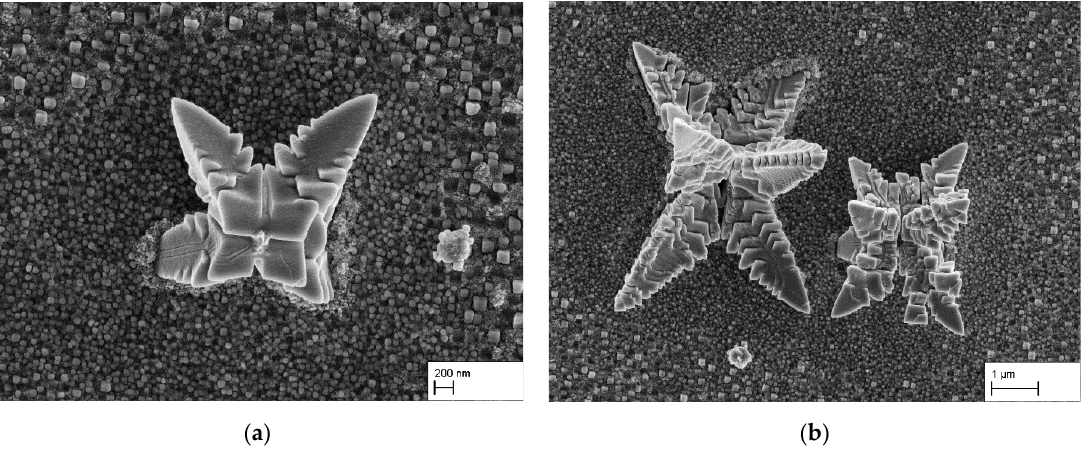
Figure 3. Deeply etched specimen with γ’ -precipitates after slow cooling to 1165 °C. ( a ) Half of a γ’ - precipitate with a view of the central splitting channel. ( b ) Two separately grown precipitates nucleated near each other.